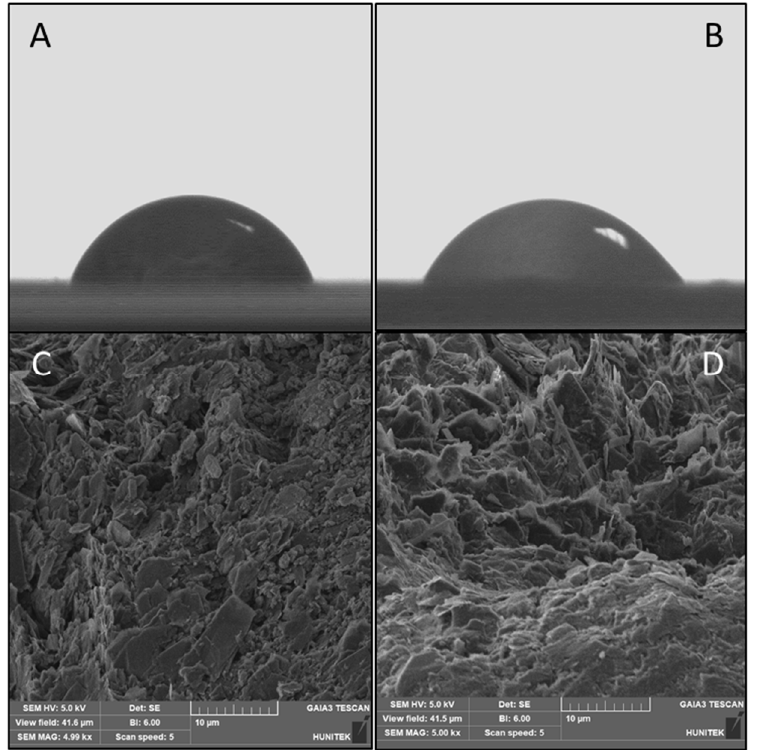
Figure 2. The surface characterization images of the MIP PGE and NIP PGE sensors. ( A ) CA image of MIP PGE sensor. ( B ) CA image of NIP PGE sensor. ( C ) SEM micrograph of MIP PGE sensor. ( D ) SEM micrograph of NIP PGE sensor.